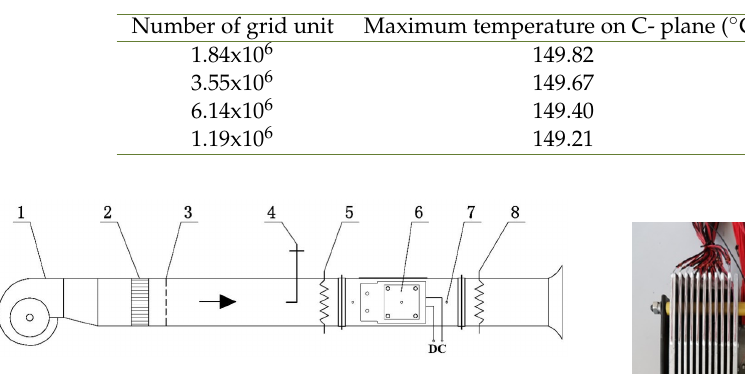
Fig. 6. Schematic of the experimental system (1 centrifugal fan, 2 cellular devices, 3 damping net, 4 device for measuring air velocity, 5 Thermal resistance for measuring temperature at the inlet, 6 Experimental specimen, 7 A hole for measuring pressure, 8 Thermal resistance for measuring temperature at the outlet.)